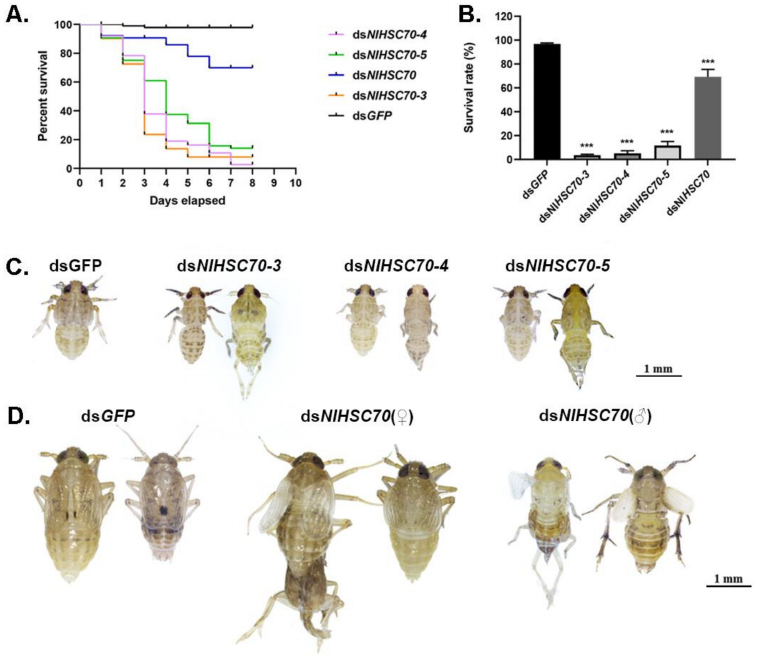
Figure 5. Effects of ds NlHSP70 s treatments on nymphs. ( A ) The survival curve of BPH at 8 days after knockdown when the 3rd instar nymphs were injected with ds NlHSP70 s. ( B ) The survival rate of BPH on day 8 after knockdown. Results are presented as mean ± SEM. *** p < 0.001 (Student t -test). ( C ) Effects of ds NlHSC70-3 , ds NlHSC70-4, and ds NlHSC70-5 on the development of nymphs. ( D ) The phenotype of nymphs after injection with ds NlHSC70 during